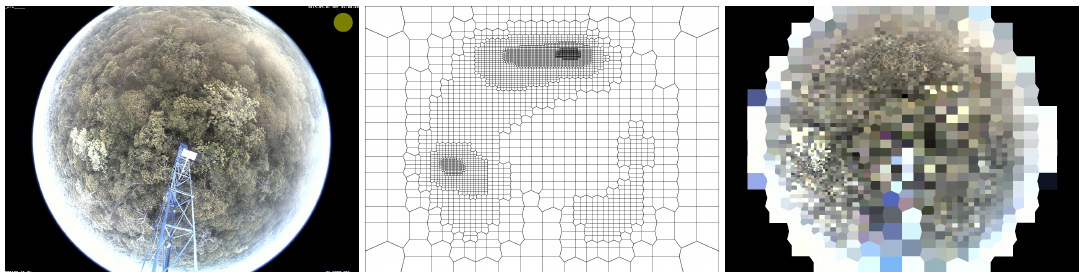
Figure 5. Example of image reconstruction. The original image ( left ) is reconstructed ( right ) using a voronoi diagram ( middle ) obtained from a model. Each voronoi cell is filled, in the right image, with the same RGB color of the cell’s central pixel in the left